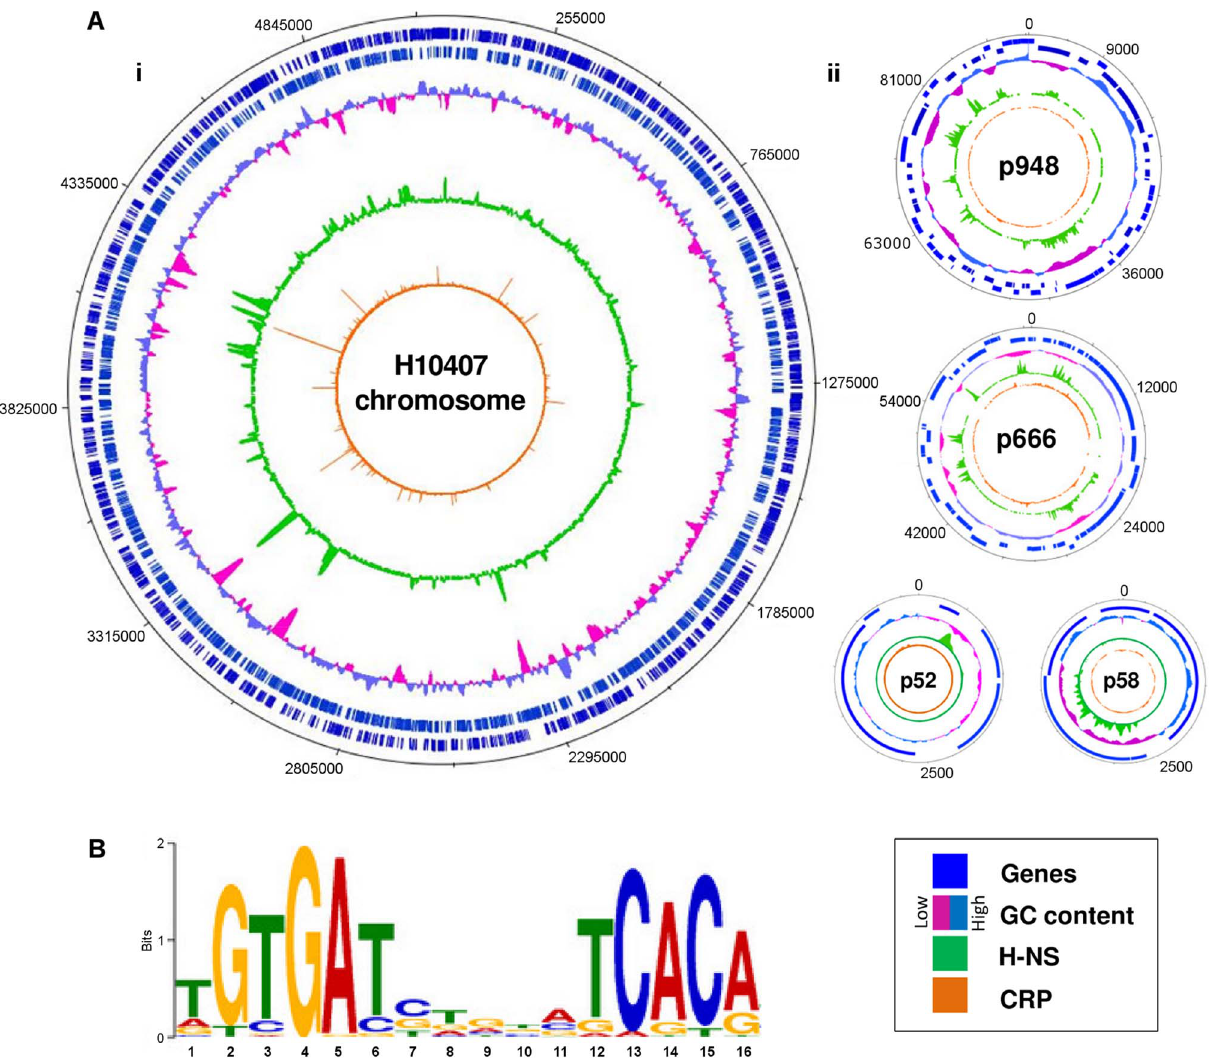
Fig. 1. Distribution of CRP and H-NS across the ETEC H10407 genome. A) The panel shows maps of the ETEC H10407 chromosome (i) and associated plasmids (ii). In each plot, tracks 1 and 2 (blue lines) show the position of genes, track 3 (purple and cyan graph) is a plot of DNA GC content, track 4 (green) is the H-NS binding profile and track 5 (orange) is the CRP binding profile. B) A DNA sequence motif generated by aligning regions of the ETEC H10407 chromosome bound by